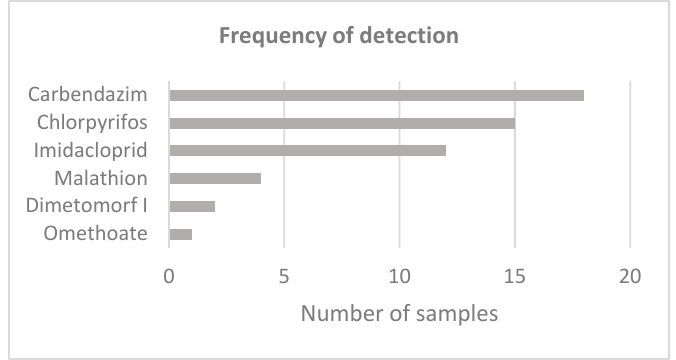
Figure 1. Frequency of detection of pesticides in Nopal.